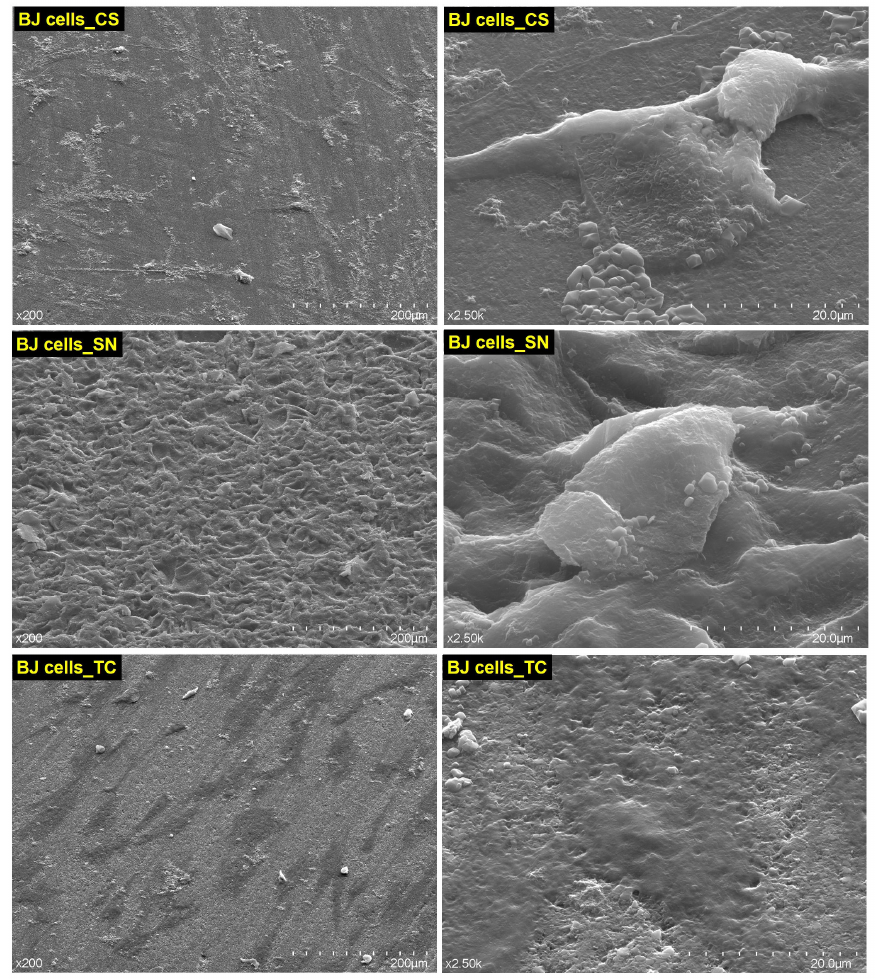
Figure 12. SEM images with the degree of adhesion of CS, SN, and TC–CAD/CAM restorative materials slices, to human BJ cells.